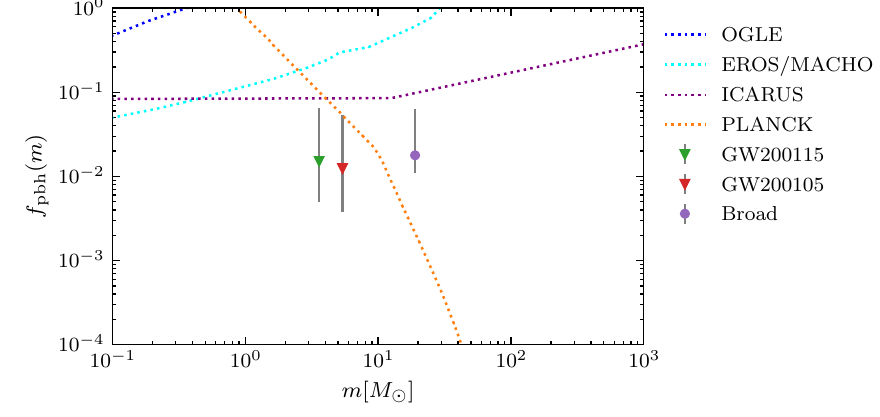
Fig. 1 Constraints on f pbh with 90% CL error bars (gray solid) inferred from the merger rates for GW200105 (red triangle) and GW200115 (green triangle), and the broad mass function (purple circle). The existing upper limits on f pbh at 90% CL from OGLE (blue), EROS/MACHO (cyan), ICARUS (purple), and Planck (orange) are shown for